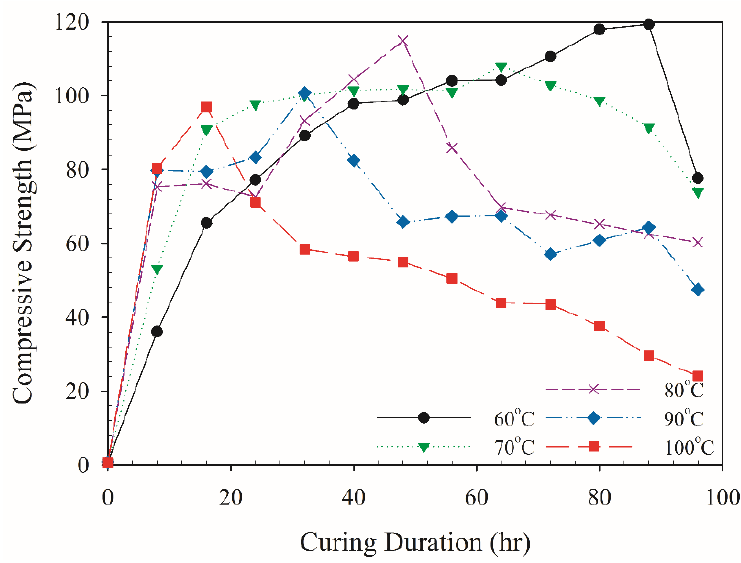
Figure 6. Variations with curing duration in the 4-day compressive strength of geopolymer specimens at various curing temperatures when AE% = 5%.